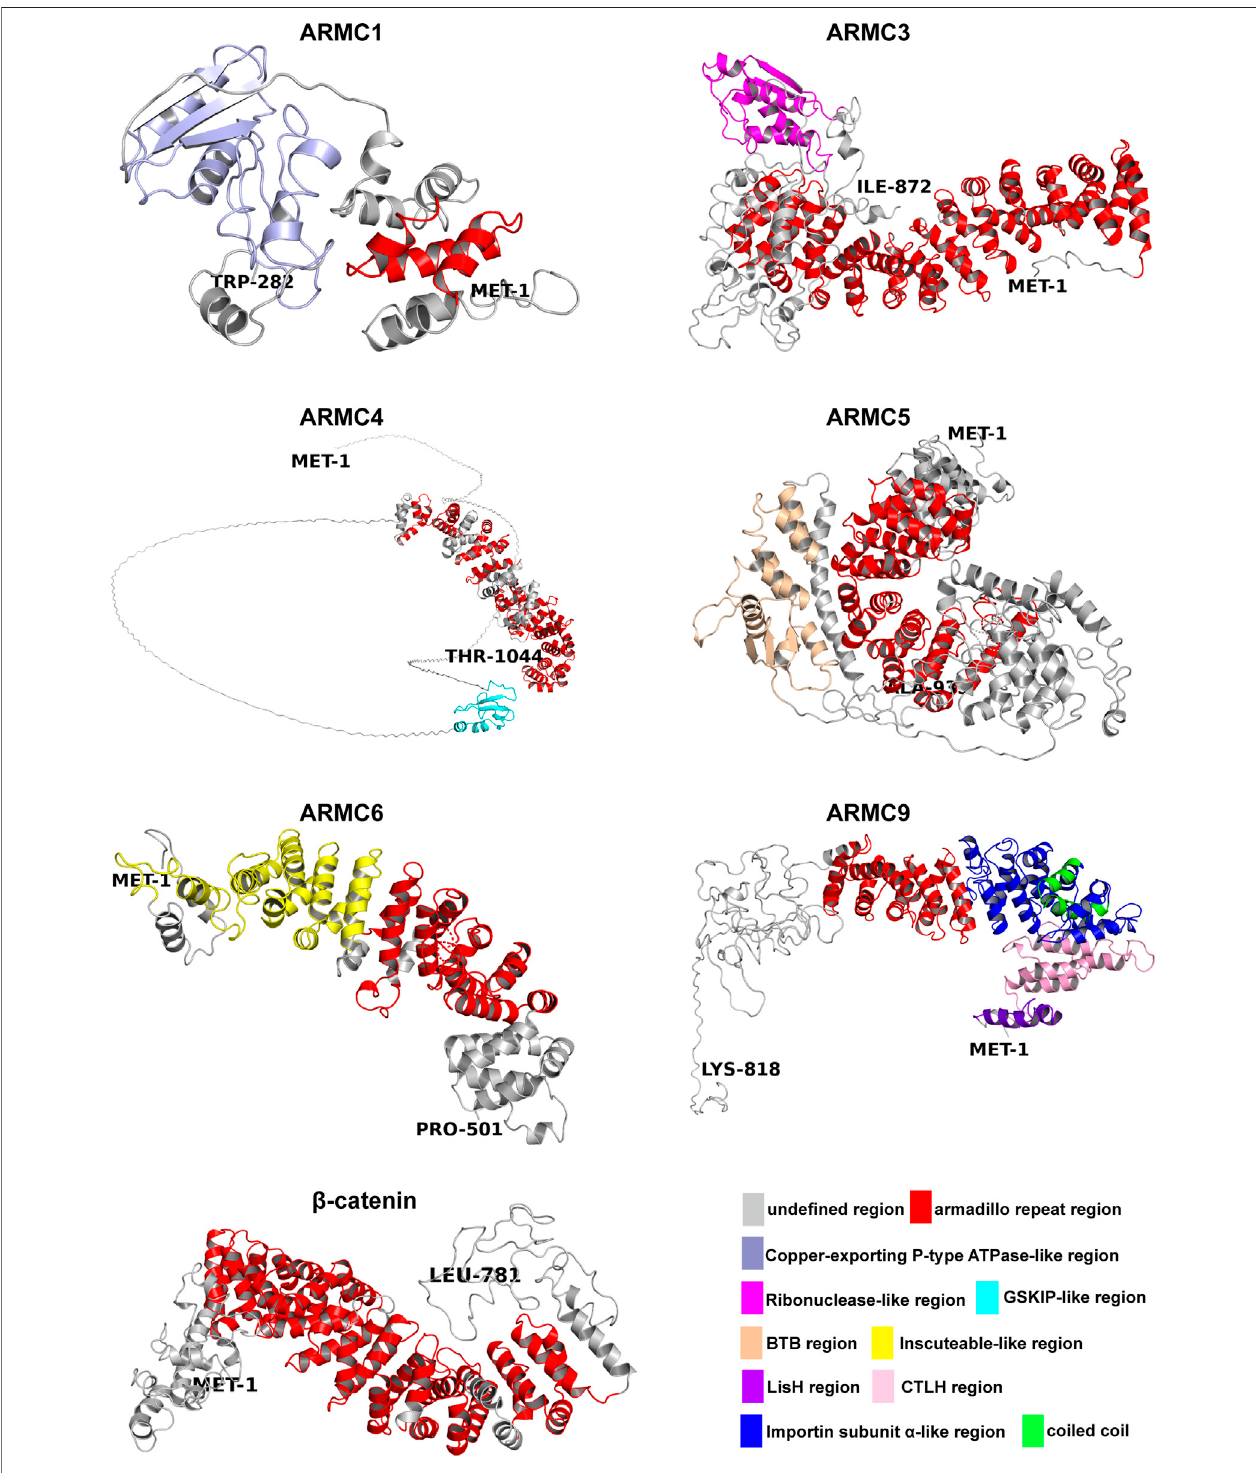
FIGURE1| StructuresoftheARMCsubfamily.TheN-terminiareshownasMET-1,andtheC-terminiareshownasanotheraminoacid.Depictedaretheunde fi ned region (gray), Armadillo repeat region (red), Copper-exporting P-type ATPase-like region (light blue), Ribonuclease-like region (magenta), GSKIP-like region (cyan), BTB region (wheat), Inscuteable-like region (yellow), LisH region (purple), CTLH region (pink), Importin subunit α -like region (blue), and coiled coil region (green). All structures (homology models) were generated using Phyre2 (Kelley et al., 2015). The pictures were generated using PyMOL (Schrodingerhe).